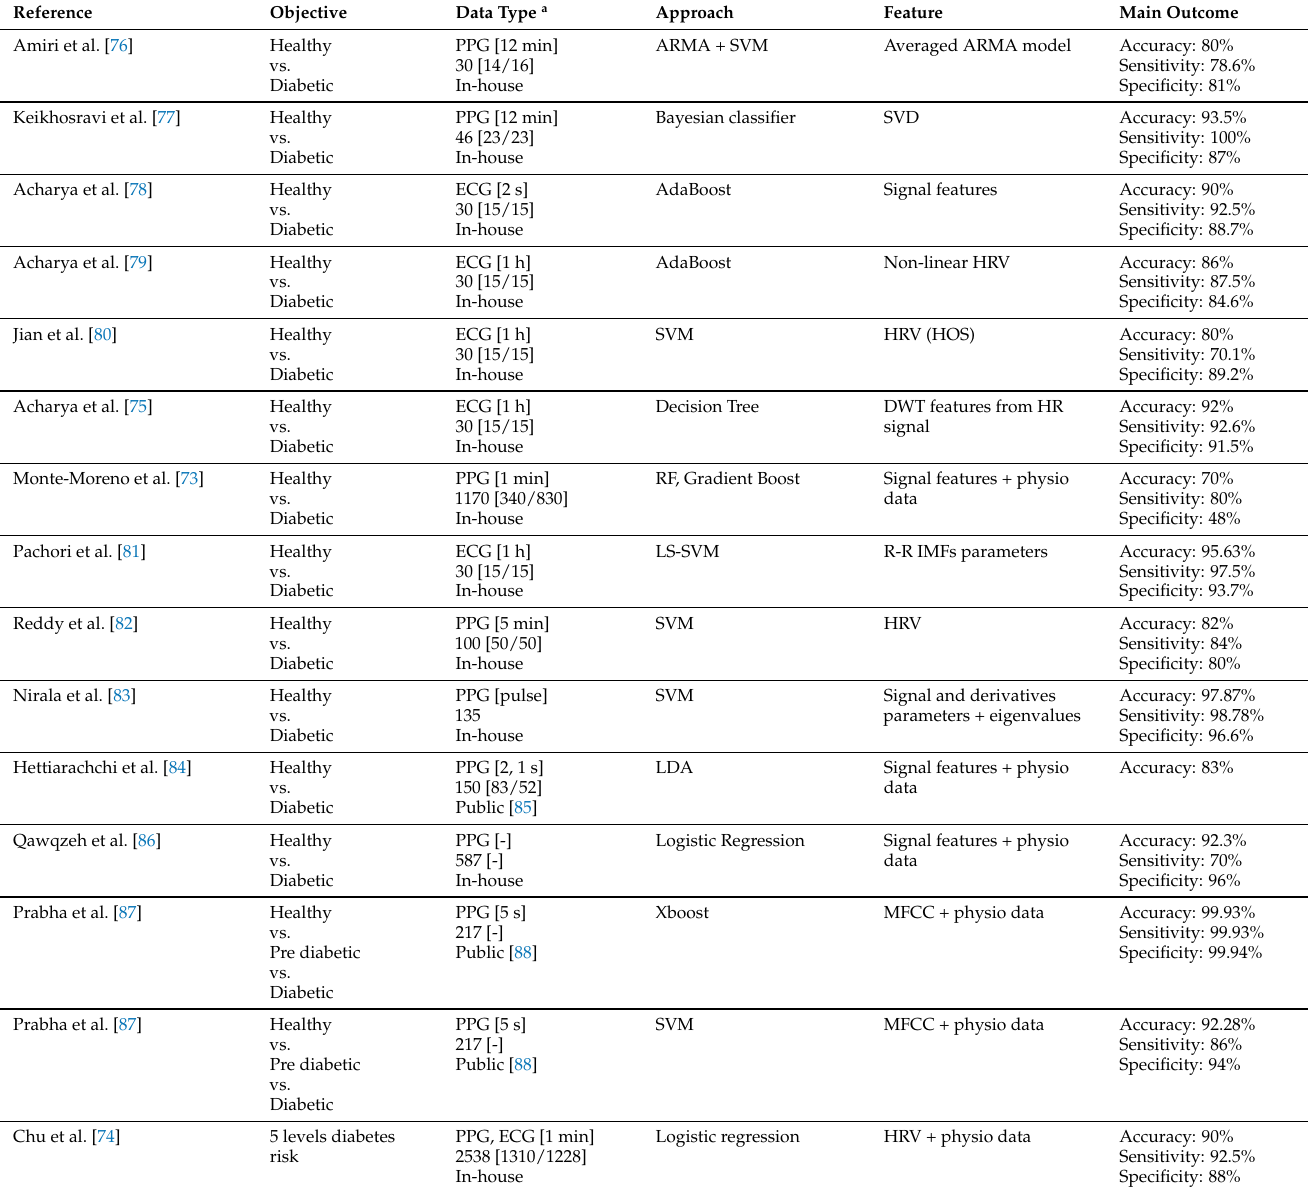
Table 5. Machine learning methods for diabetes